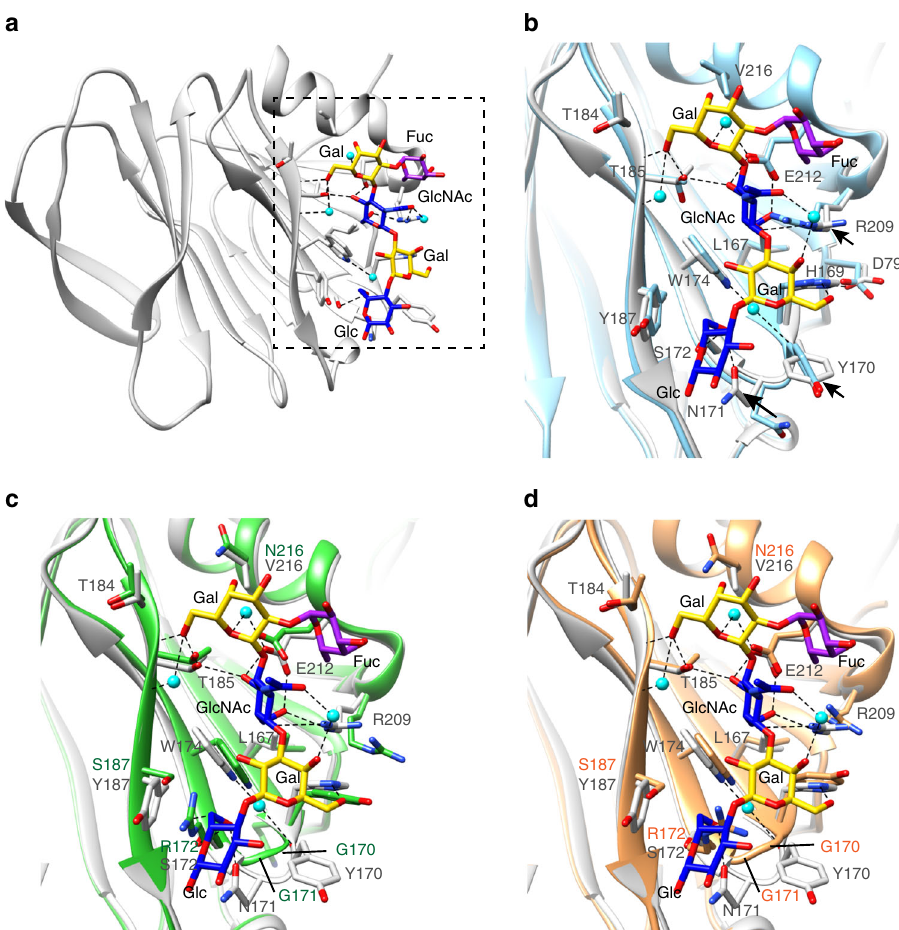
Fig. 3 Structure of P[6] RV3 VP8* in complex with H type I pentasaccharide. a Structure of P[6] RV3 VP8* is shown in gray ribbon, with the bound glycan in stick model. The glycan residues are labeled. b Superimposition of P[6] VP8* apo structure (cyan) and the liganded P[6] VP8* (gray) shows the structural change of VP8* upon binding to H type I. The changes of sidechain orientations are indicated by black arrows. c Structural alignment of the structure of P[6] RV3 VP8* (gray) in complex with H type I and P[4] DS-1 VP8* (green) apo structure (PDB ID: 2AEN) shows how the Gal-GlcNAc moieties can bind to the conserved the amino acids in P[4] VP8*, and how the changes in P[4] DS-1 lead to loss of interaction with the Glc at the reducing end of H-type I glycan. d Structural alignment of the structure of P[6] RV3 VP8* (gray) in complex with H type I and P[8] Wa VP8* (orange) apo